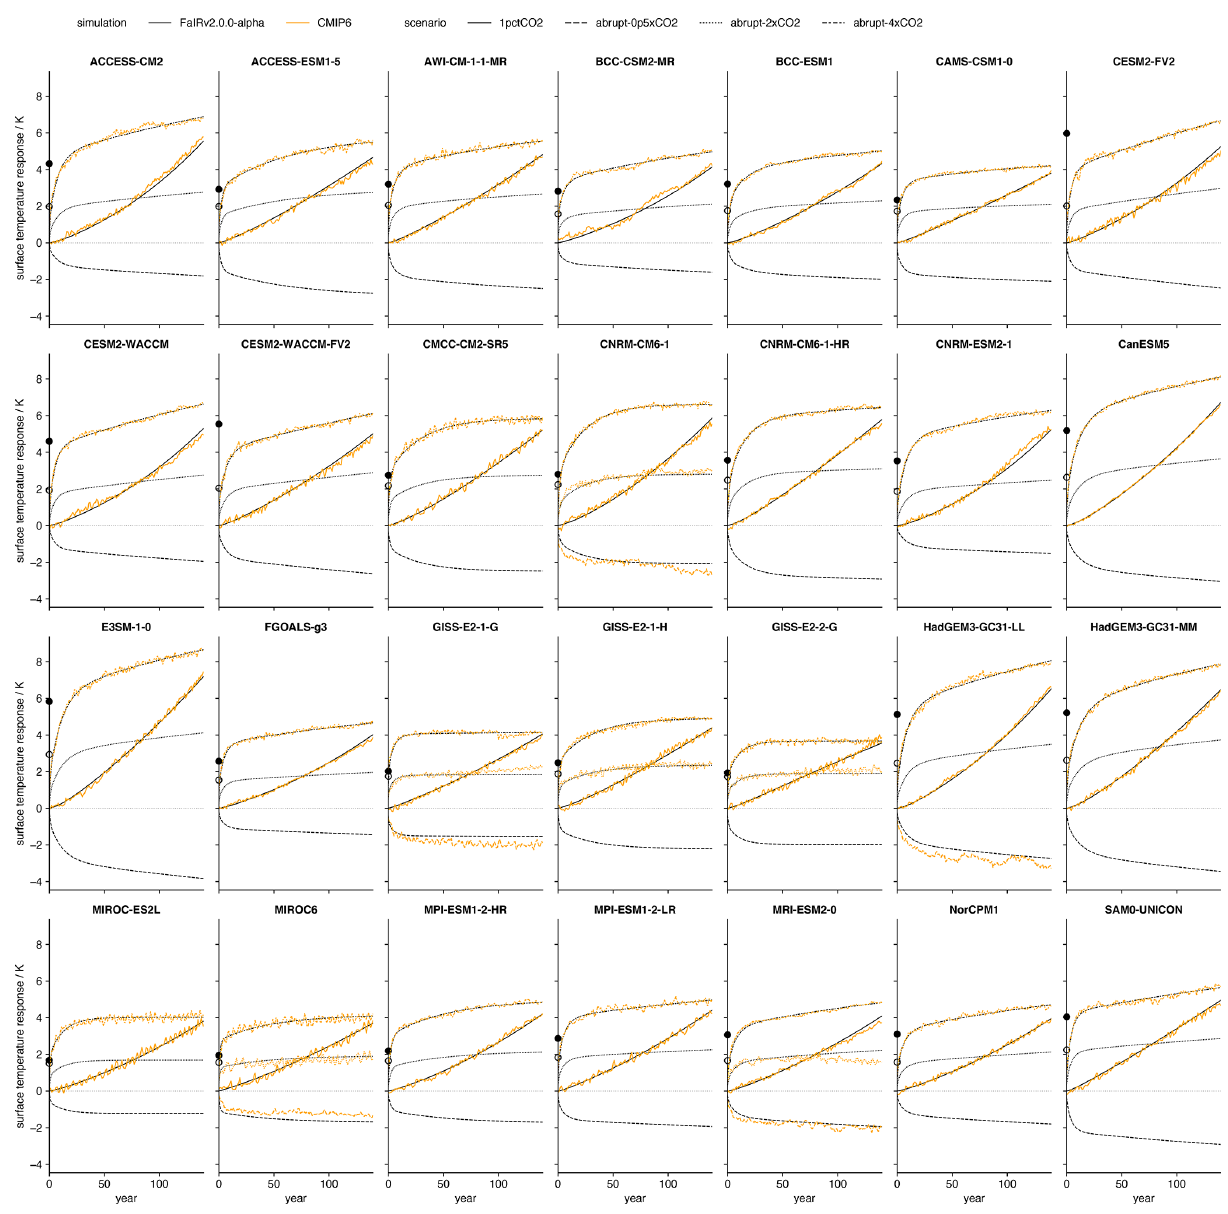
Figure 3. FaIRv2.0.0 emulation of CMIP6 model response to the abrupt-4xCO2, abrupt-2xCO2, abrupt-0p5xCO2, and 1pctCO2 experiments. The black line shows FaIRv2.0.0-alpha emulation, and the orange line shows CMIP6 model data where available. Emulation parameters were fit using the abrupt-4xCO2 and 1pctCO2 experiments so the abrupt-2xCO2 and abrupt-0p5xCO2 simulations can be considered as verification experiments for the models where the data for these experiments is available. Filled and unfilled dots over the y axis indicate the assessed model ECS and TCR, respectively (see Table